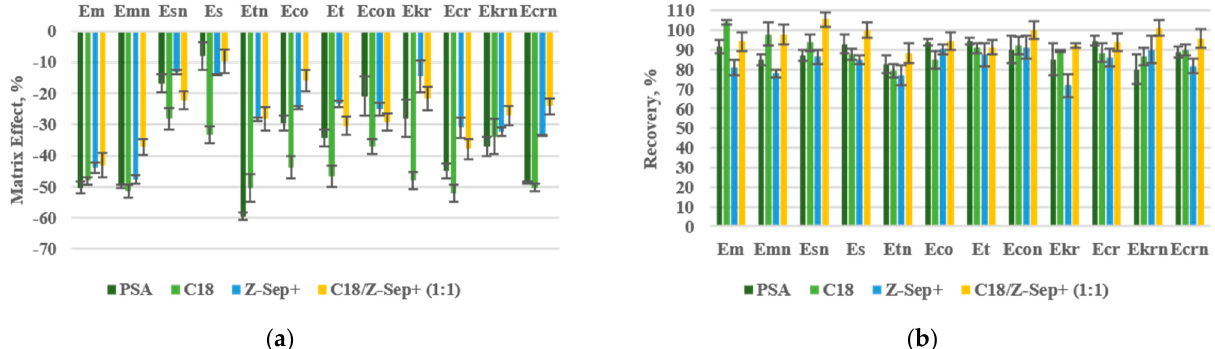
Figure 1. Optimization of the sorbent in the d-SPE step of the QuEChERS procedure. Effect of the kind of dispersive sorbent in the matrix effect ( a ); effect of the kind of sorbent in the recovery study ( b ).